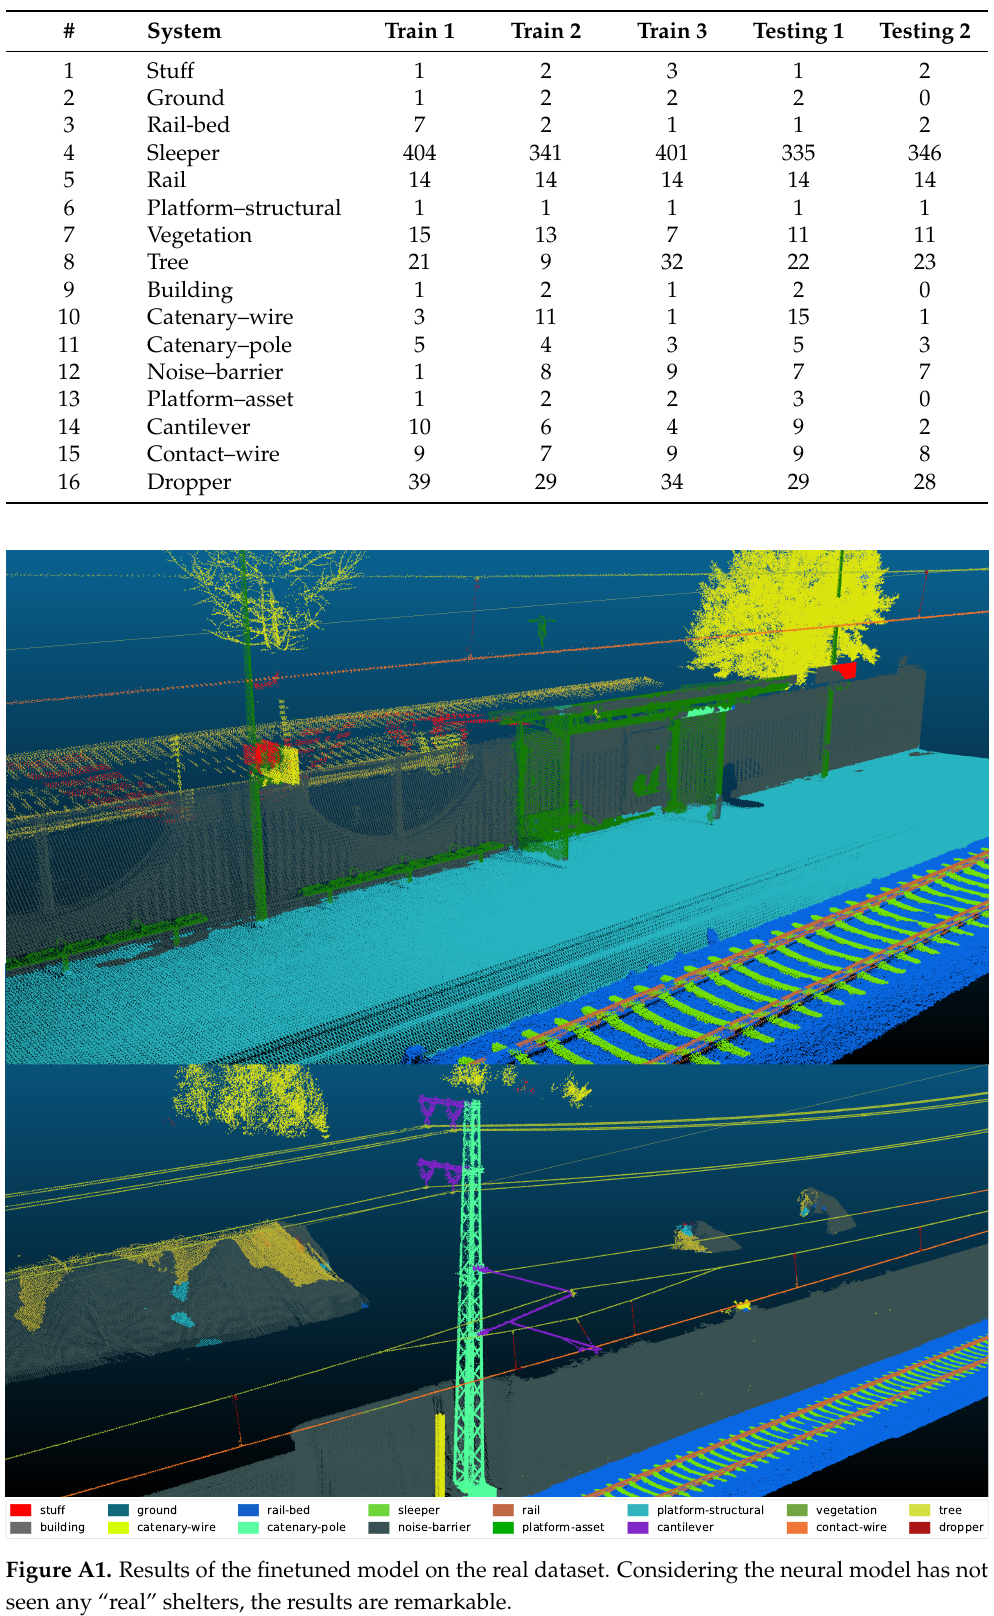
Table A1. Object count for the experiments. Objects might span adjacent sets.